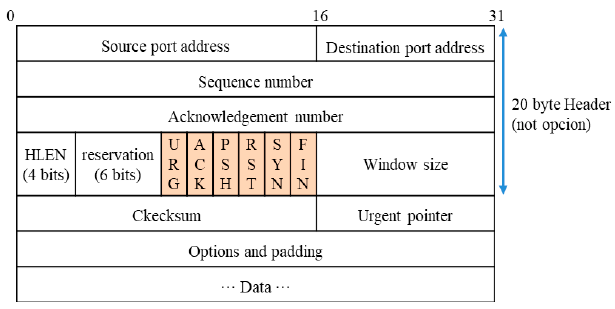
Figure 3. TCP header and control flag structure.